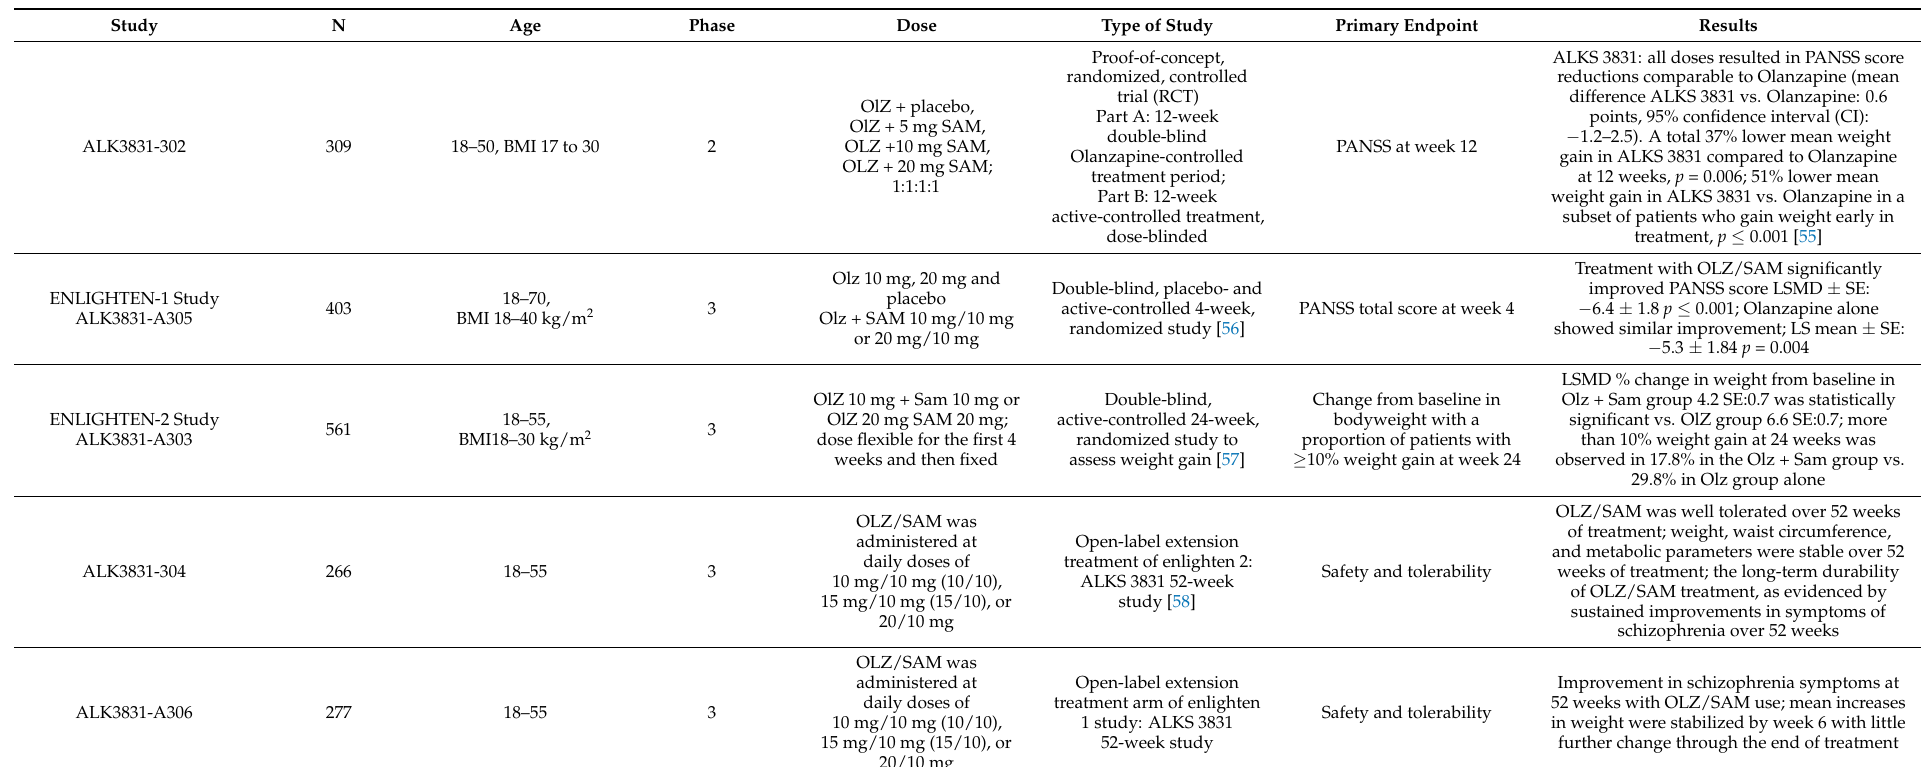
Table 6. Samidorphan and Olanzapine